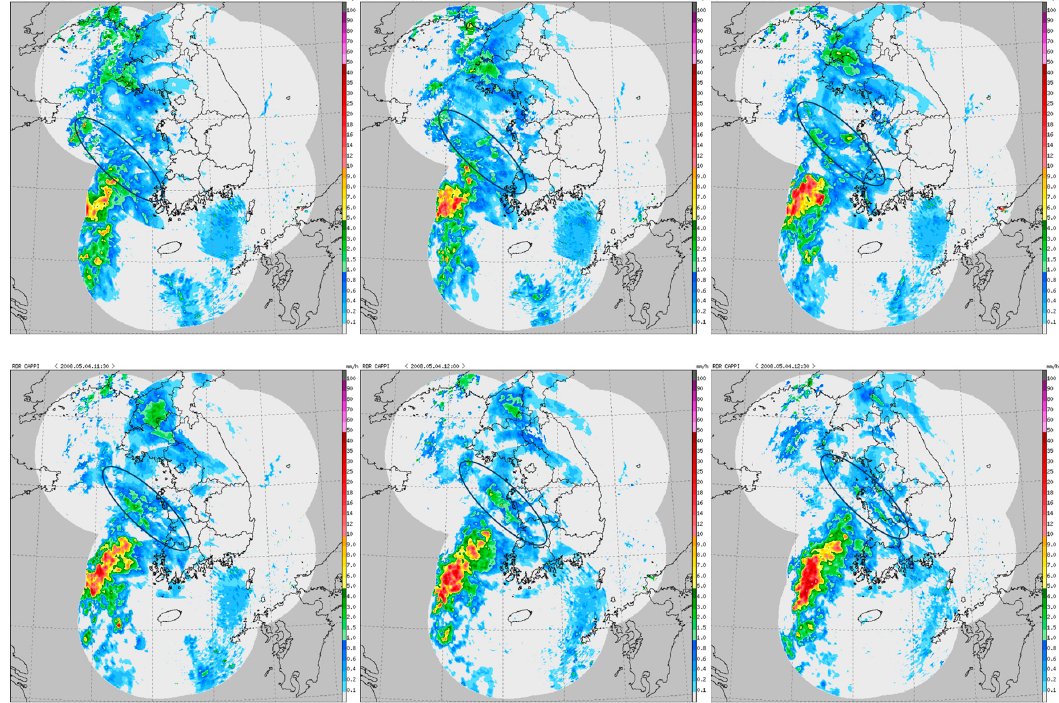
Figure 5. Moving atmospheric pressure disturbance observed in weather radar